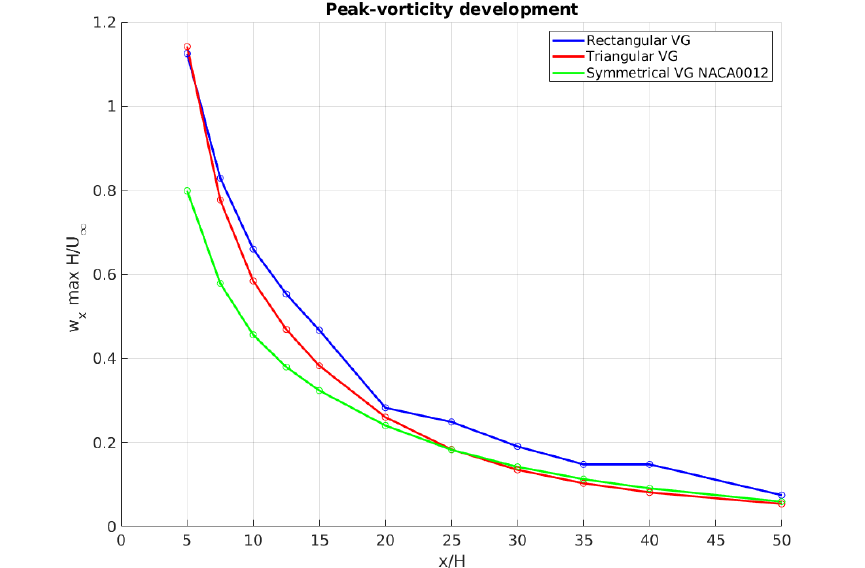
Figure 11. Peak vorticity development of the primary vortex in streamwise